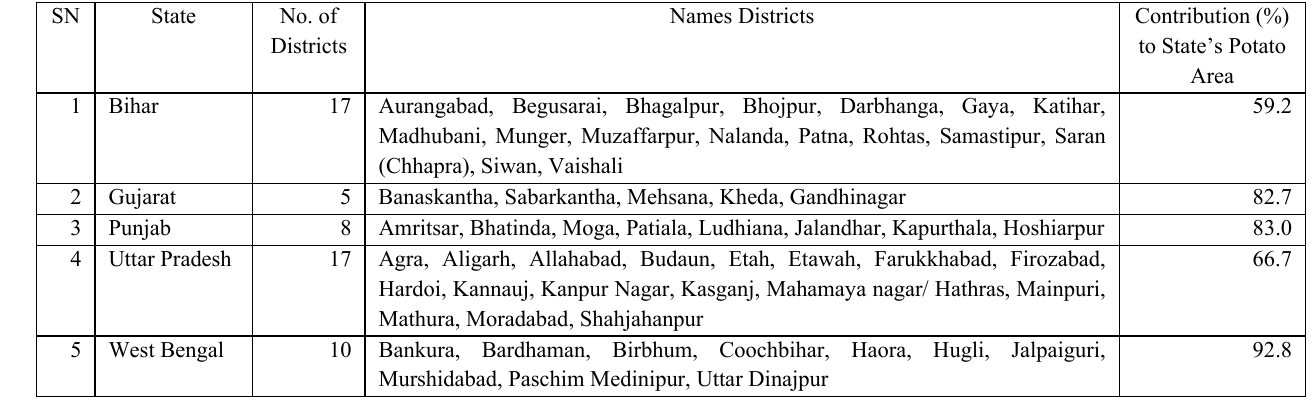
Table 1. List of Study Districts for potato crop